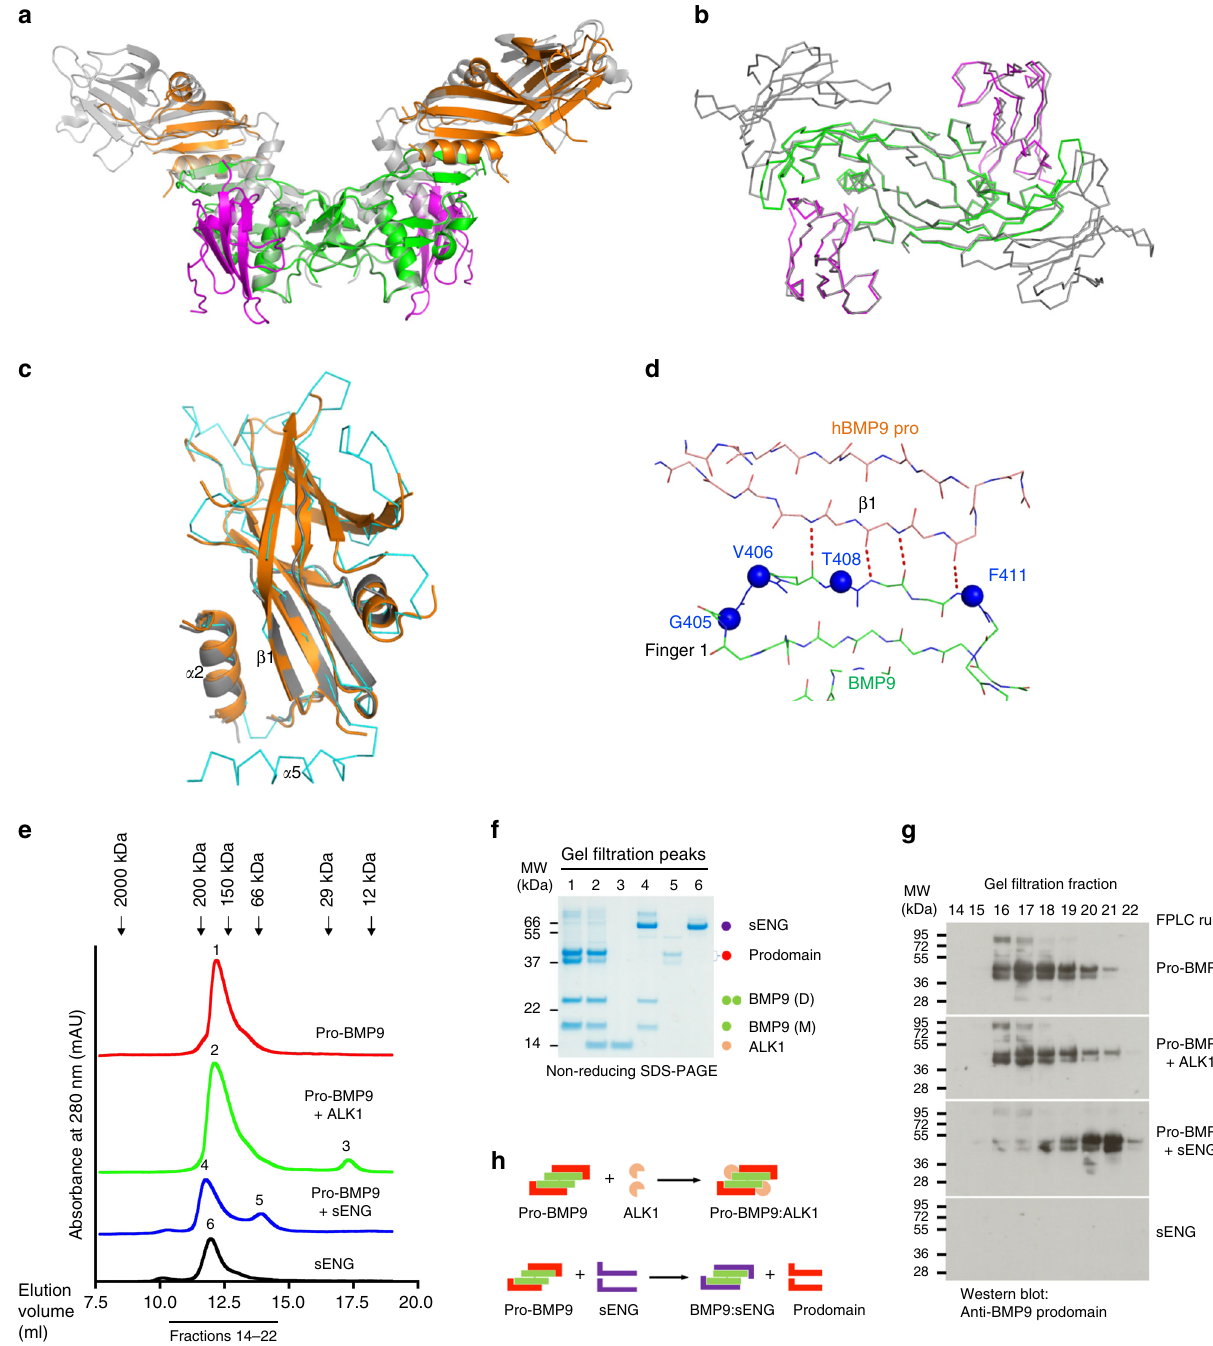
Fig. 7e, both BMP2 and BMP9 induced robust ALP activity in C2C12 cells. While the presence of CV2 inhibited BMP2-induced ALP activity potently and in a dose-dependent manner, no inhibition was detected for BMP9-mediated ALP induction. These cell assays veri fi ed our structural analysis that CV2 does not inhibit BMP9